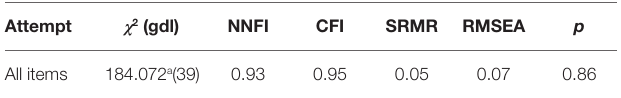
TABLE 3 | Fit indices –